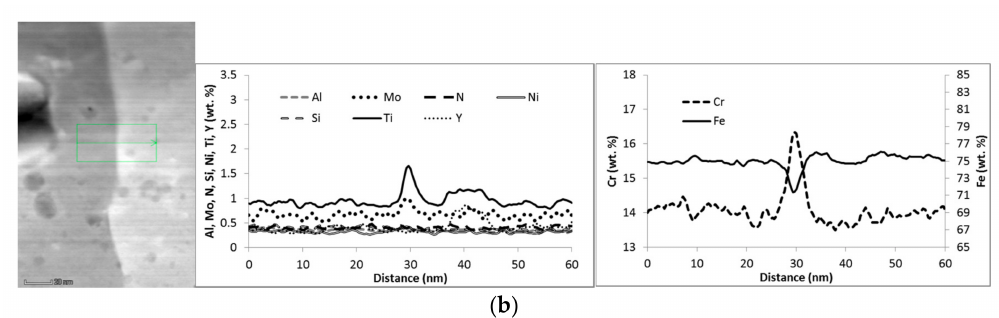
Figure 4. STEM-EDX maps and line profile of chemical composition across the grain boundary in the AR condition: ( a ) Maps; ( b ) The line shows enrichment with Cr, Ti, Mo, and slight Ni at the grain boundary.